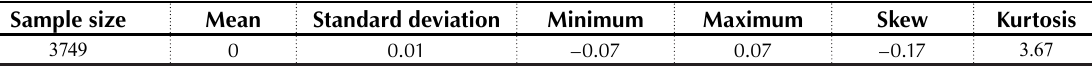
Table 1. Summary statistics of the returns